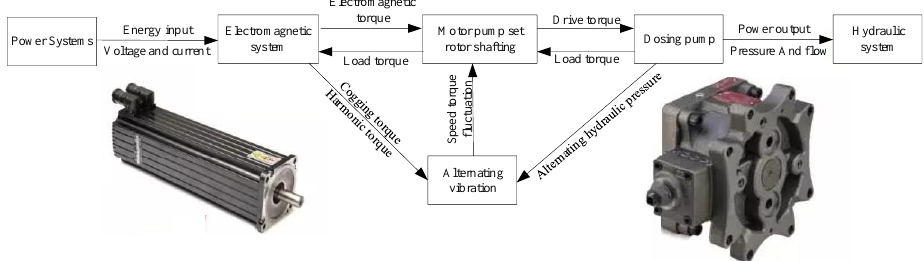
Figure 11. Electro-hydraulic coupling relationship diagram of the motor pump unit.